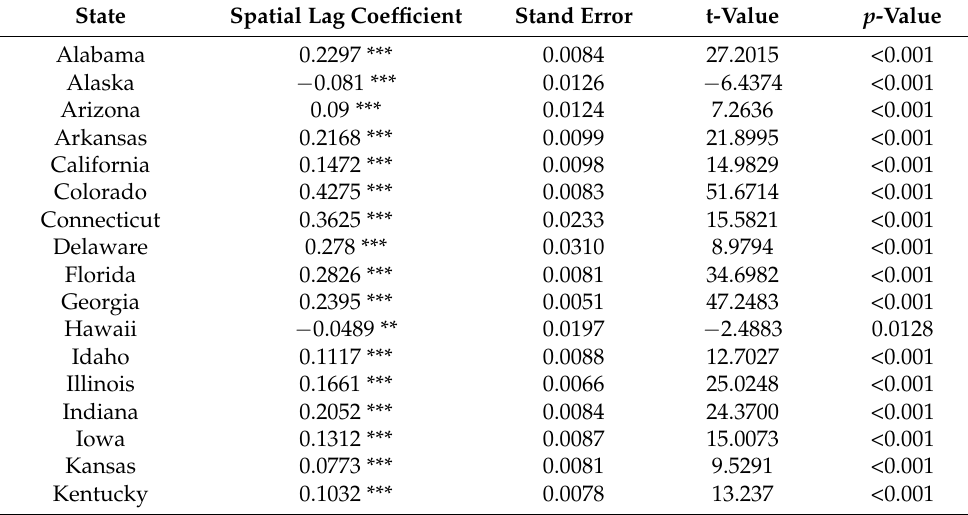
Table 1. Summary of spatial lag coefficients in the SLM-SIRu